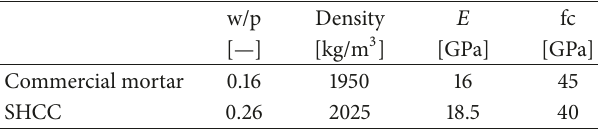
Table 2: Comparison of properties of commercial mortar and SHCC. w/p Density 𝐸 fc [—] [kg/m 3 ] [GPa]